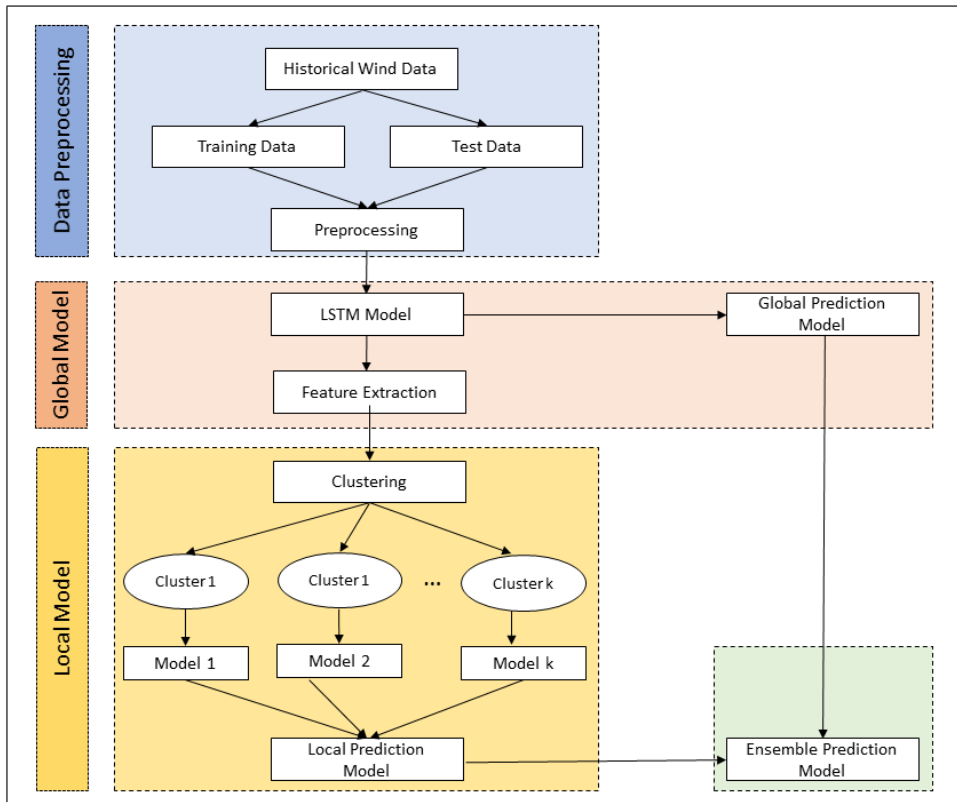
Figure 4. The flowchart of the proposed forecasting